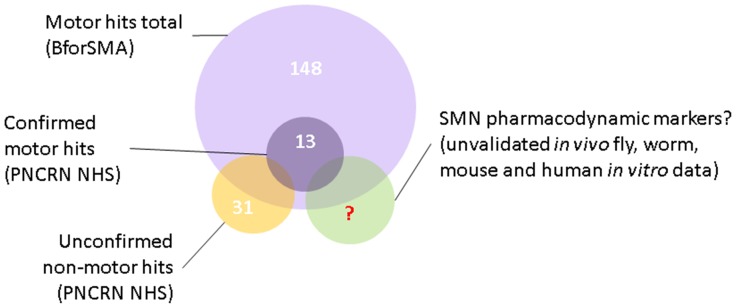
Several types of biomarkers for SMA-MAP analytes.SMA biomarkers were identified for their regression to motor function and non-motor outcome measures. The analytes have been confirmed and validated to different degrees and will require more validation in prospective, longitudinal studies to determine their utility as biomarkers for disease progression and pharmacodynamic response.